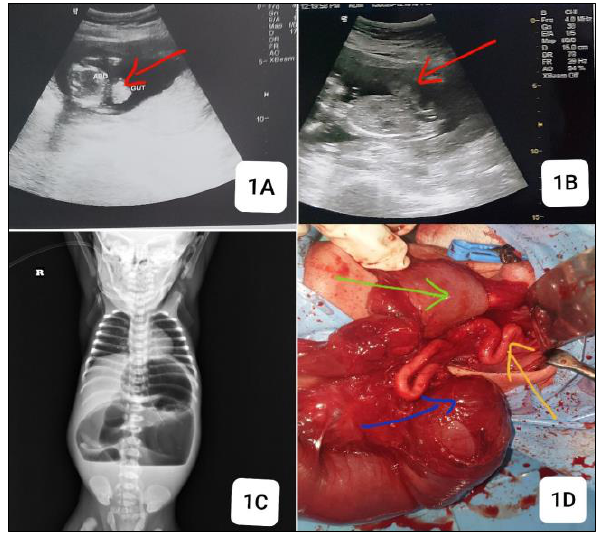
Figure 1: 1A and 1B) antenatal scans at 16 and 20 weeks, with red arrow showing gastroschisis. 1C) plain abdominal erect X-ray with dilated small bowel and 3 air-fluid levels. 1D) intraoperative finding of dilated stomach (green arrow), jejunal atresia (blue arrow), and short length atretic colon (yellow arrow).